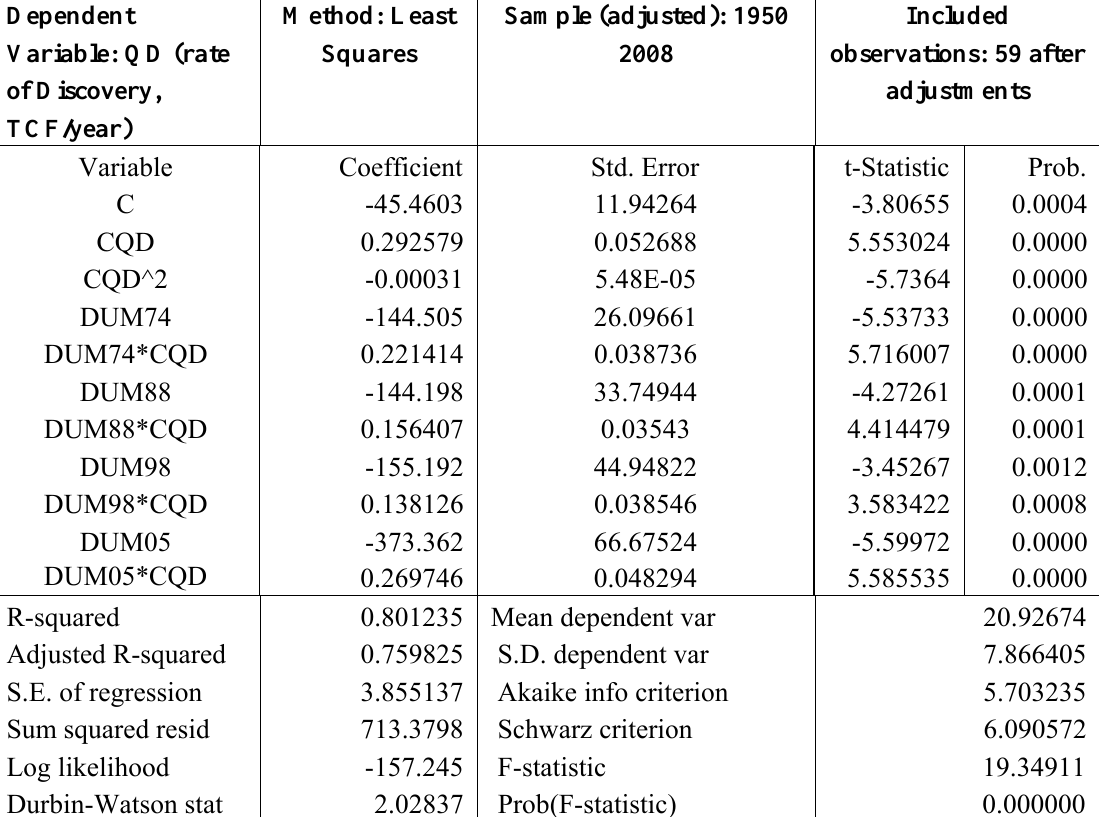
Table 12. Five Cycle Hubbert Curve Estimate.